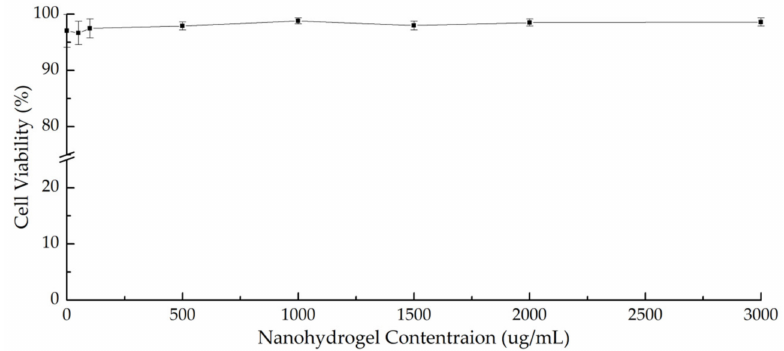
Figure 11. Cytotoxicity results of NanoC by LDH assay in RAW 264.7 cell